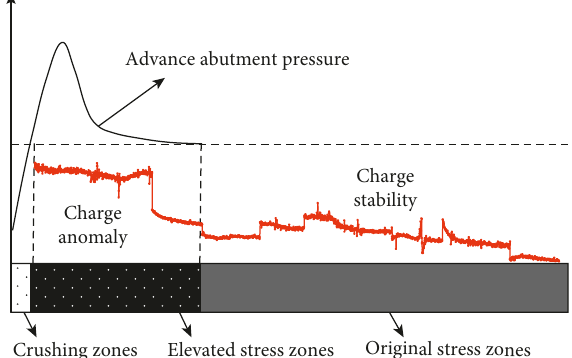
Figure 14: Relationship between advance abutment pressure and charge in front working